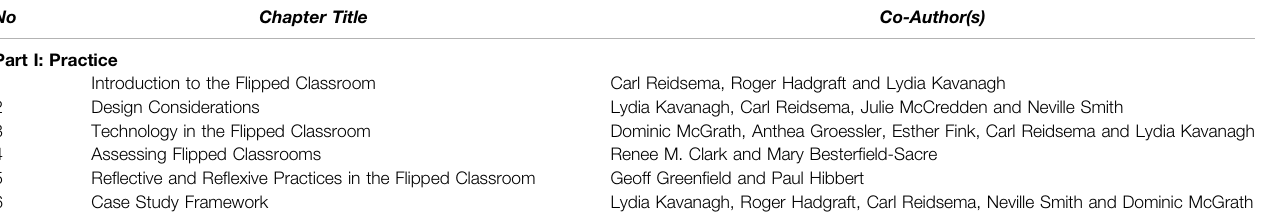
TABLE 1 | Table of contents of Part I: Practice summarized from Reidsema et al. (2017).